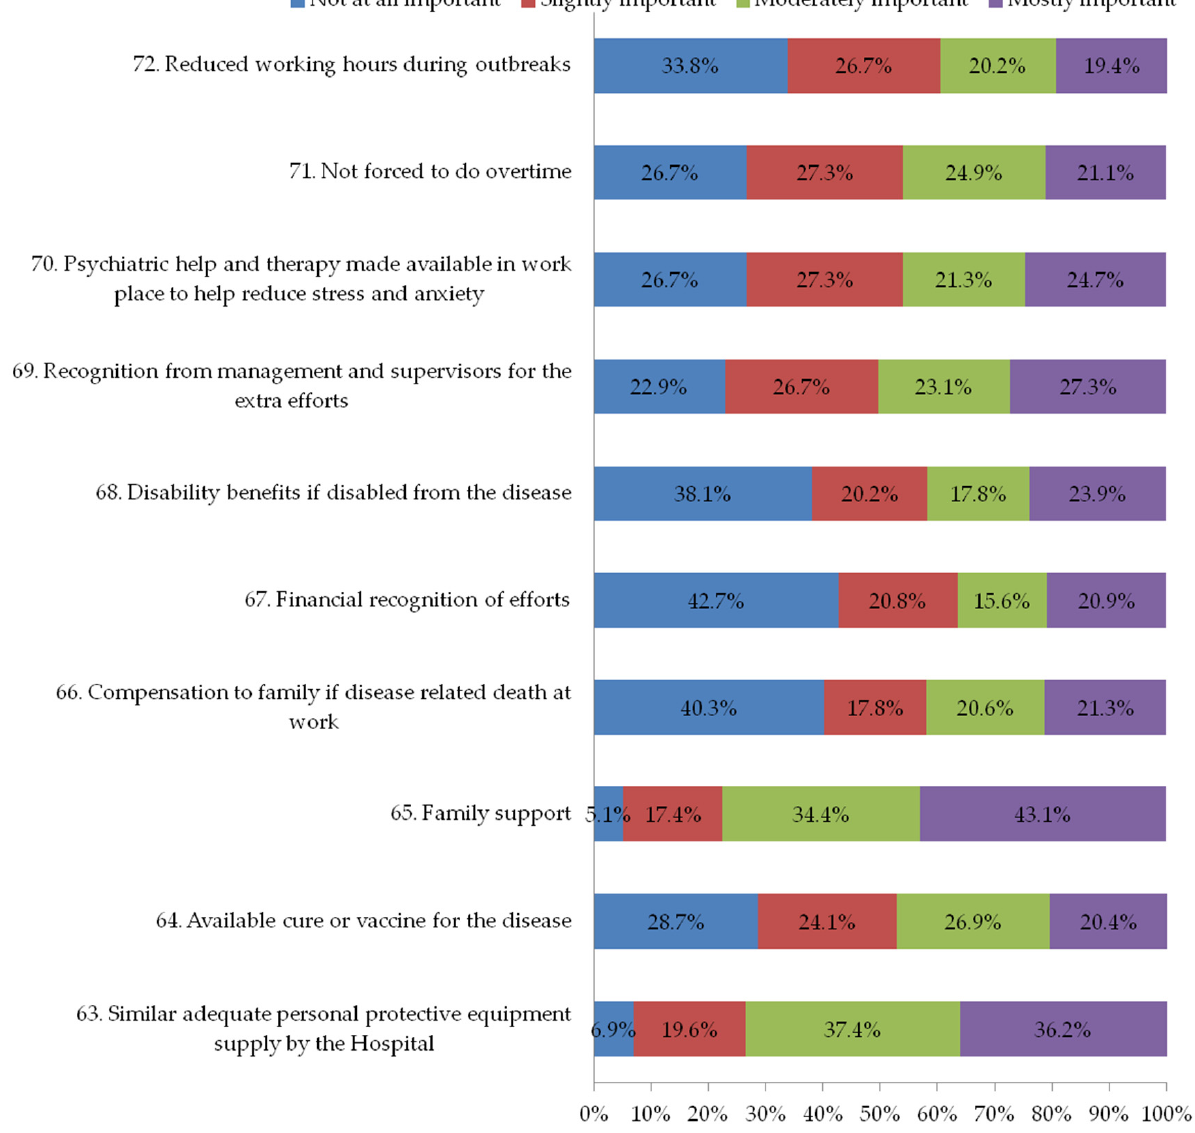
Figure 5. Motivational factors to encourage the continuation of work in future outbreaks.